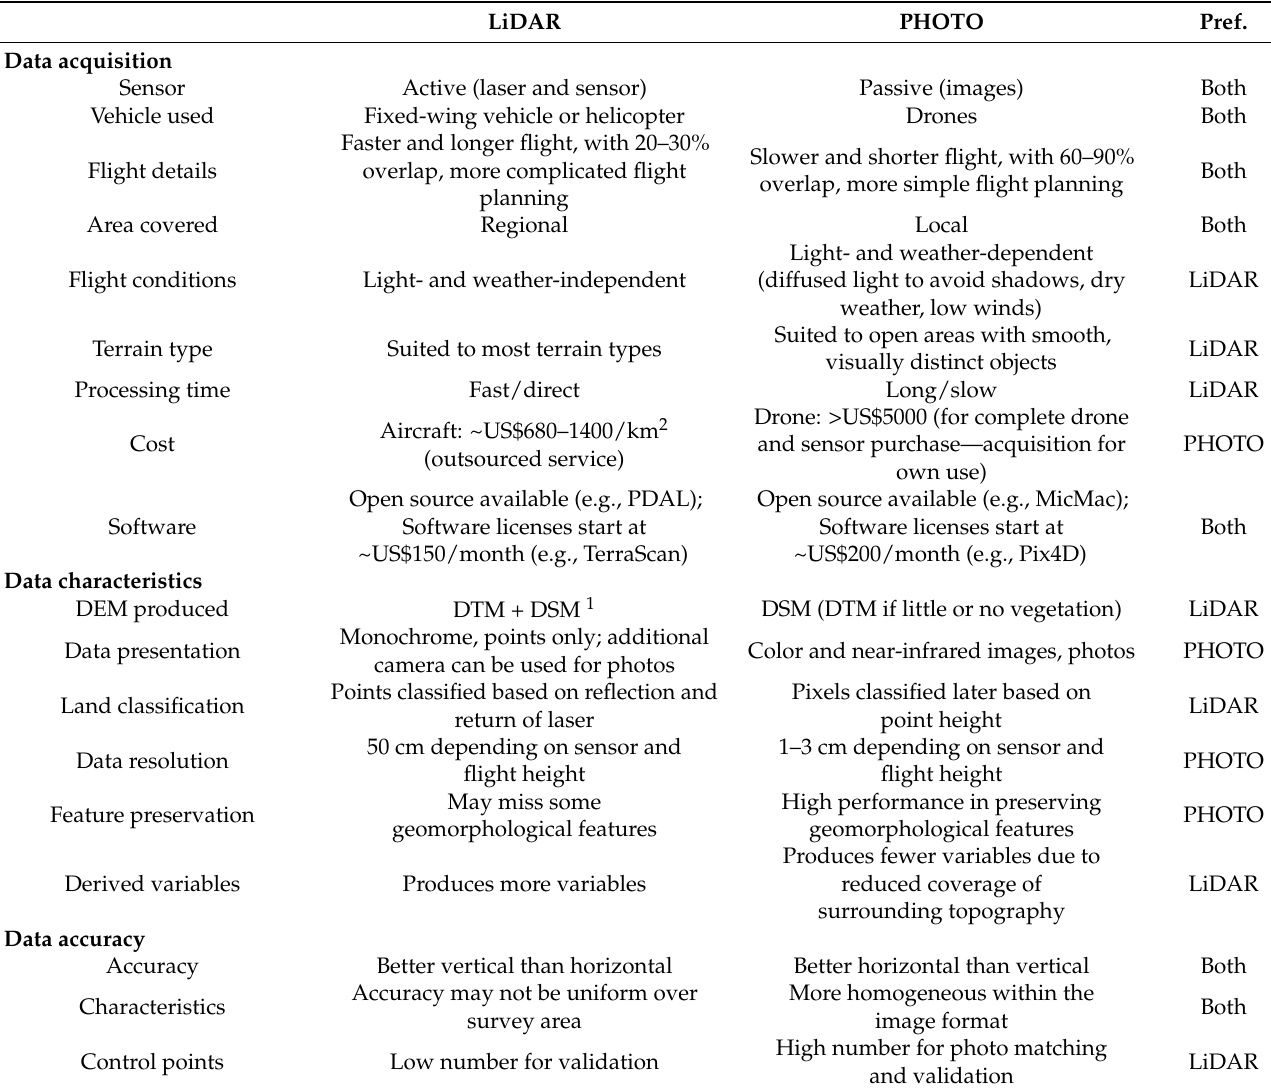
Table 3. Key differences between airborne LiDAR and drone photogrammetry (PHOTO) technologies to acquire DEMs, with regards to technical aspects and data characteristics. An additional column ‘Pref.’ indicates whether LiDAR or PHOTO are preferred for a given aspect, where “Both” is marked in cases where the preferred technology is context dependent. See [15,23,29,30,63] for review articles of these two